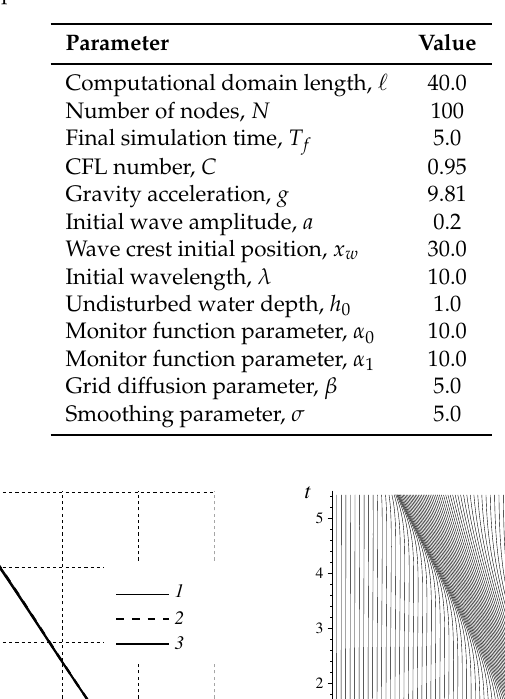
Table 4. The numerical parameters used in validations of the nonlinear shallow water equations solver.